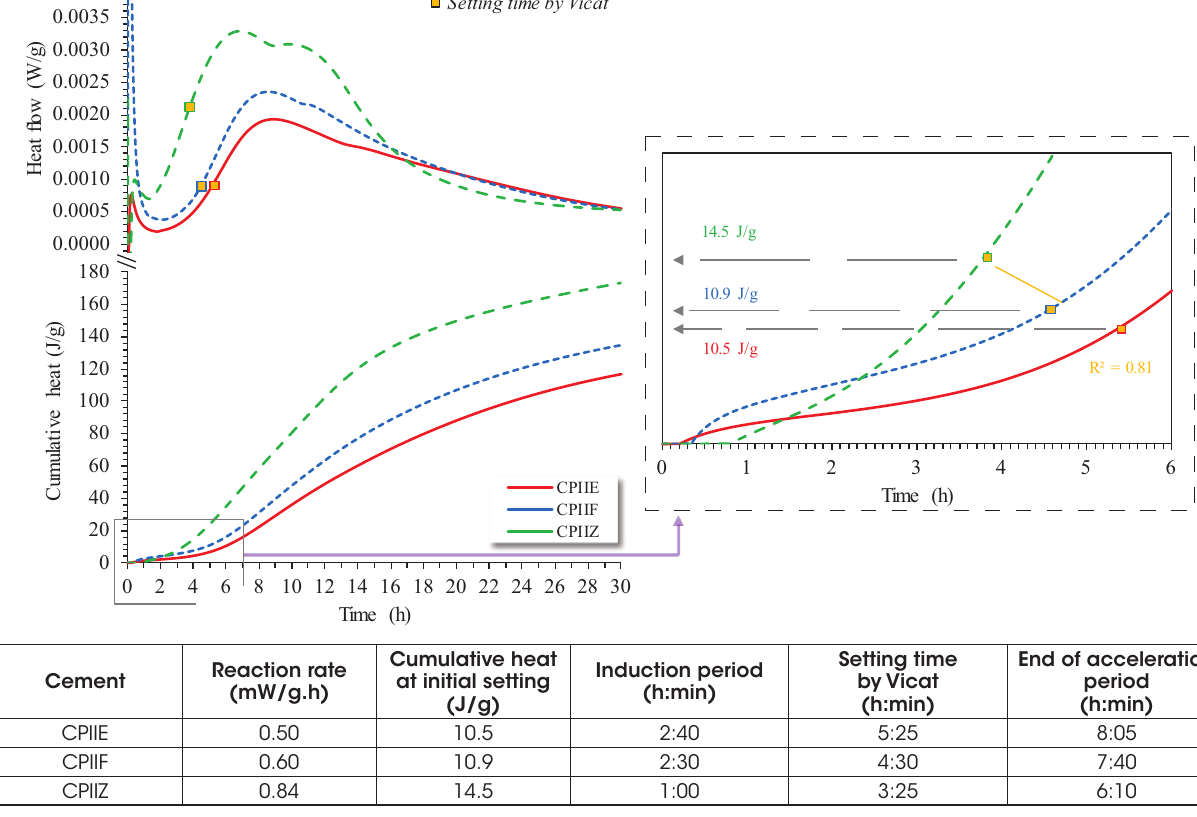
Flow heat during the hydration reaction (above) and cumulative heat (below). The table shows the reaction rate, cumulative heat in the setting time, induction period and the end of the acceleration period